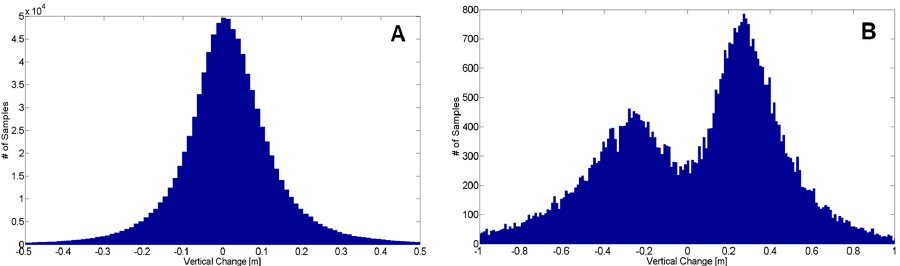
Figure 10. Distribution of vertical changes observed between the 2012 and 2008 DEMs. ( A ): vertical changes observed within the inventory mapped landslides (reference), and ( B ): vertical changes mapped by the proposed approach within the inventory mapped landslides.